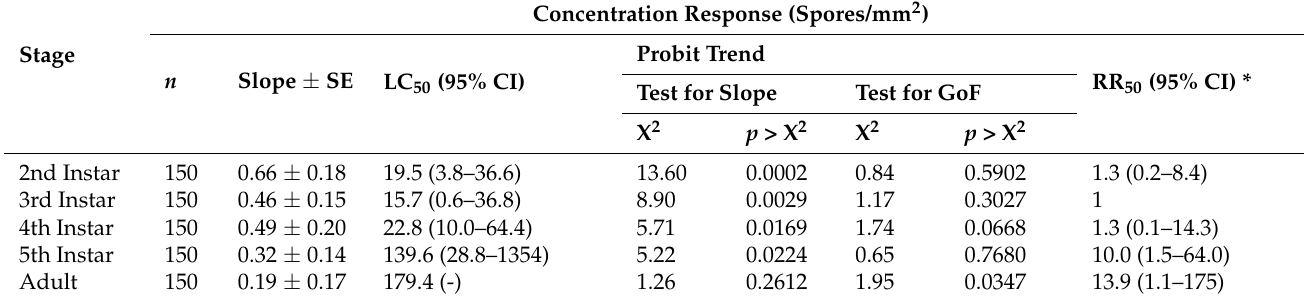
Table 3. Lethal mortality-response (LC 50 ) of different stages of Nezara viridula treated by direct spray with Beauveria bassiana , Mississippi Delta native strain NI8.